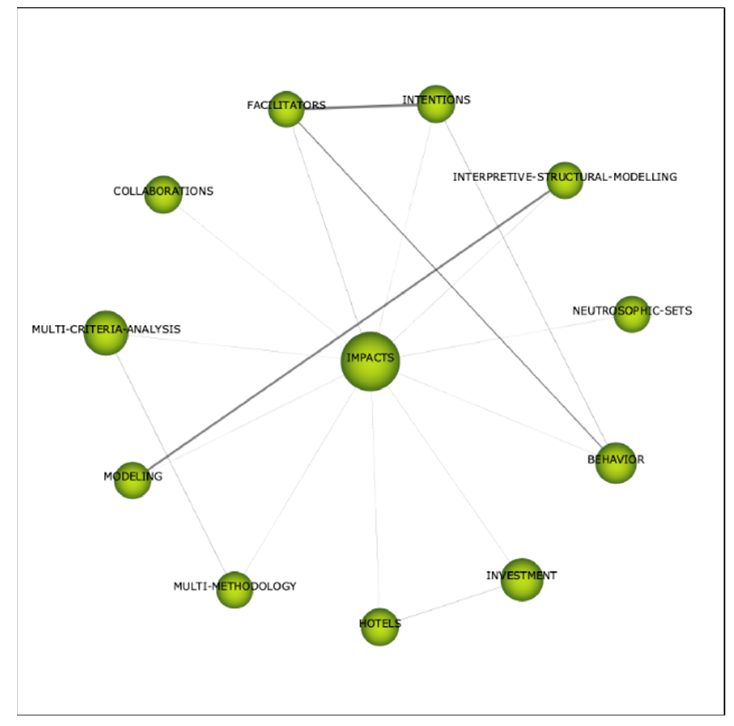
Figure A4. Impact cluster network.